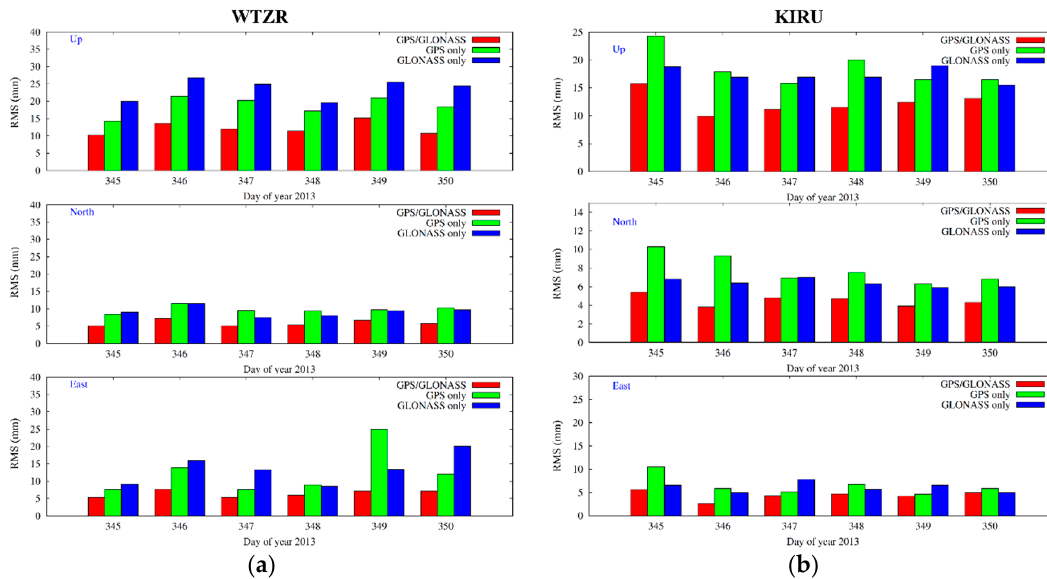
Figure 10. ( a ) RMS in mm of the kinematic coordinates in the up (top), north (middle), and east (bottom) components for WTZR (Wettzell, Germany) station. ( b ) RMS in mm of the kinematic coordinates in the up (top), north (middle), and east (bottom) components for KIRU (Kiruna, Sweden) station. For both stations, the selected period is from December 11, 2013, to December 17, 2013.